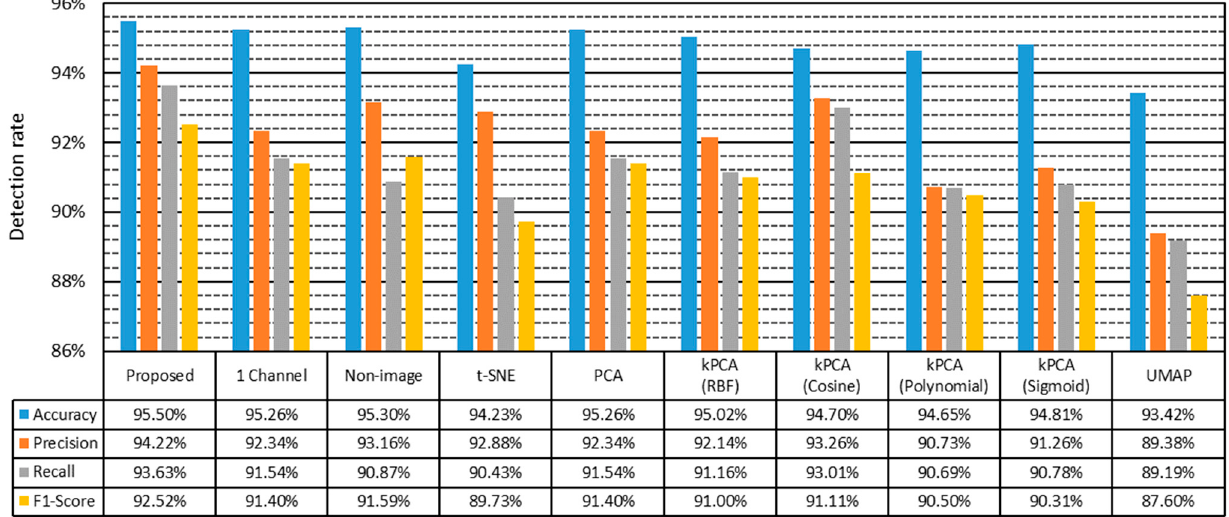
Figure 6. Detection rate for each algorithm on the CSE-CIC-IDS2018 dataset.